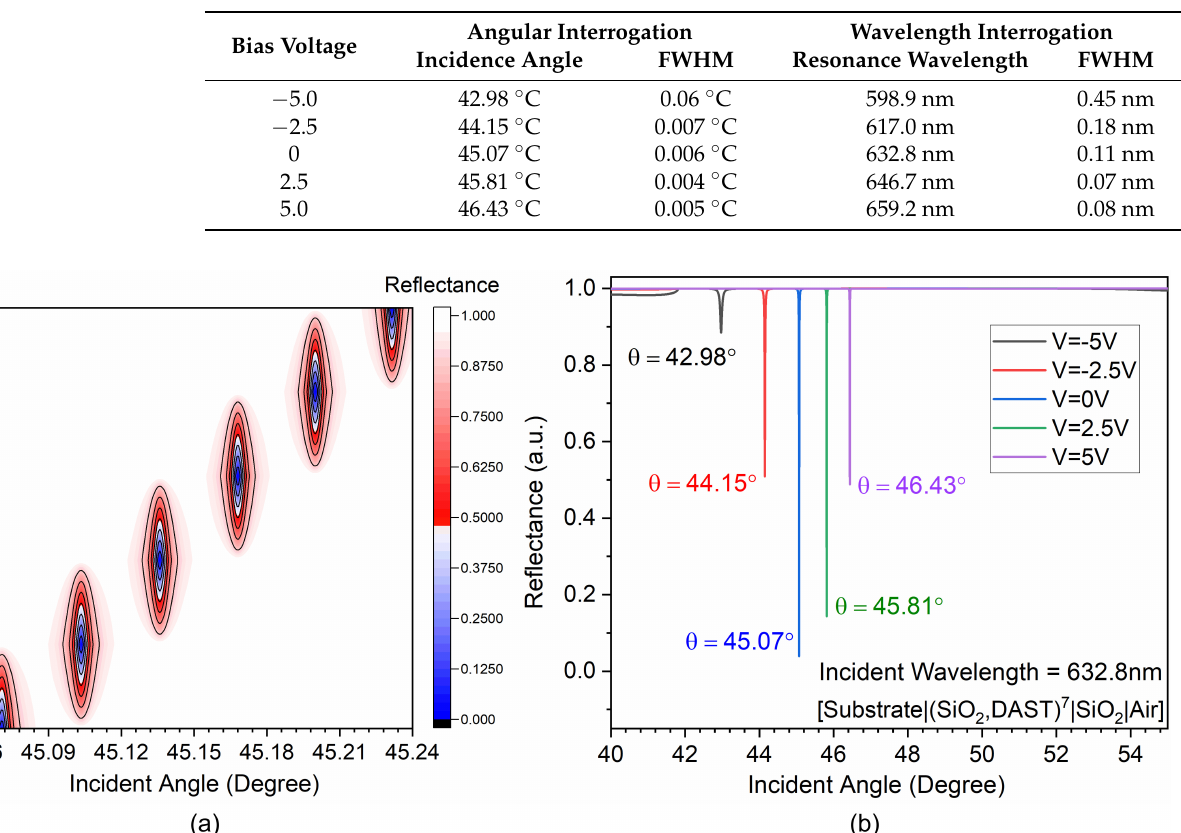
Table 2. Effect of applied voltage on both incidence angle and excitation wavelength.